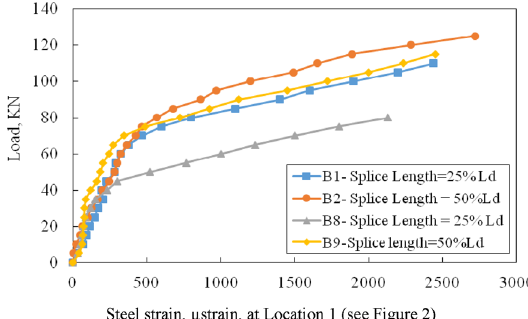
Fig. 22 Load–longitudinal steel strain of Beams B1, B2, B8 and